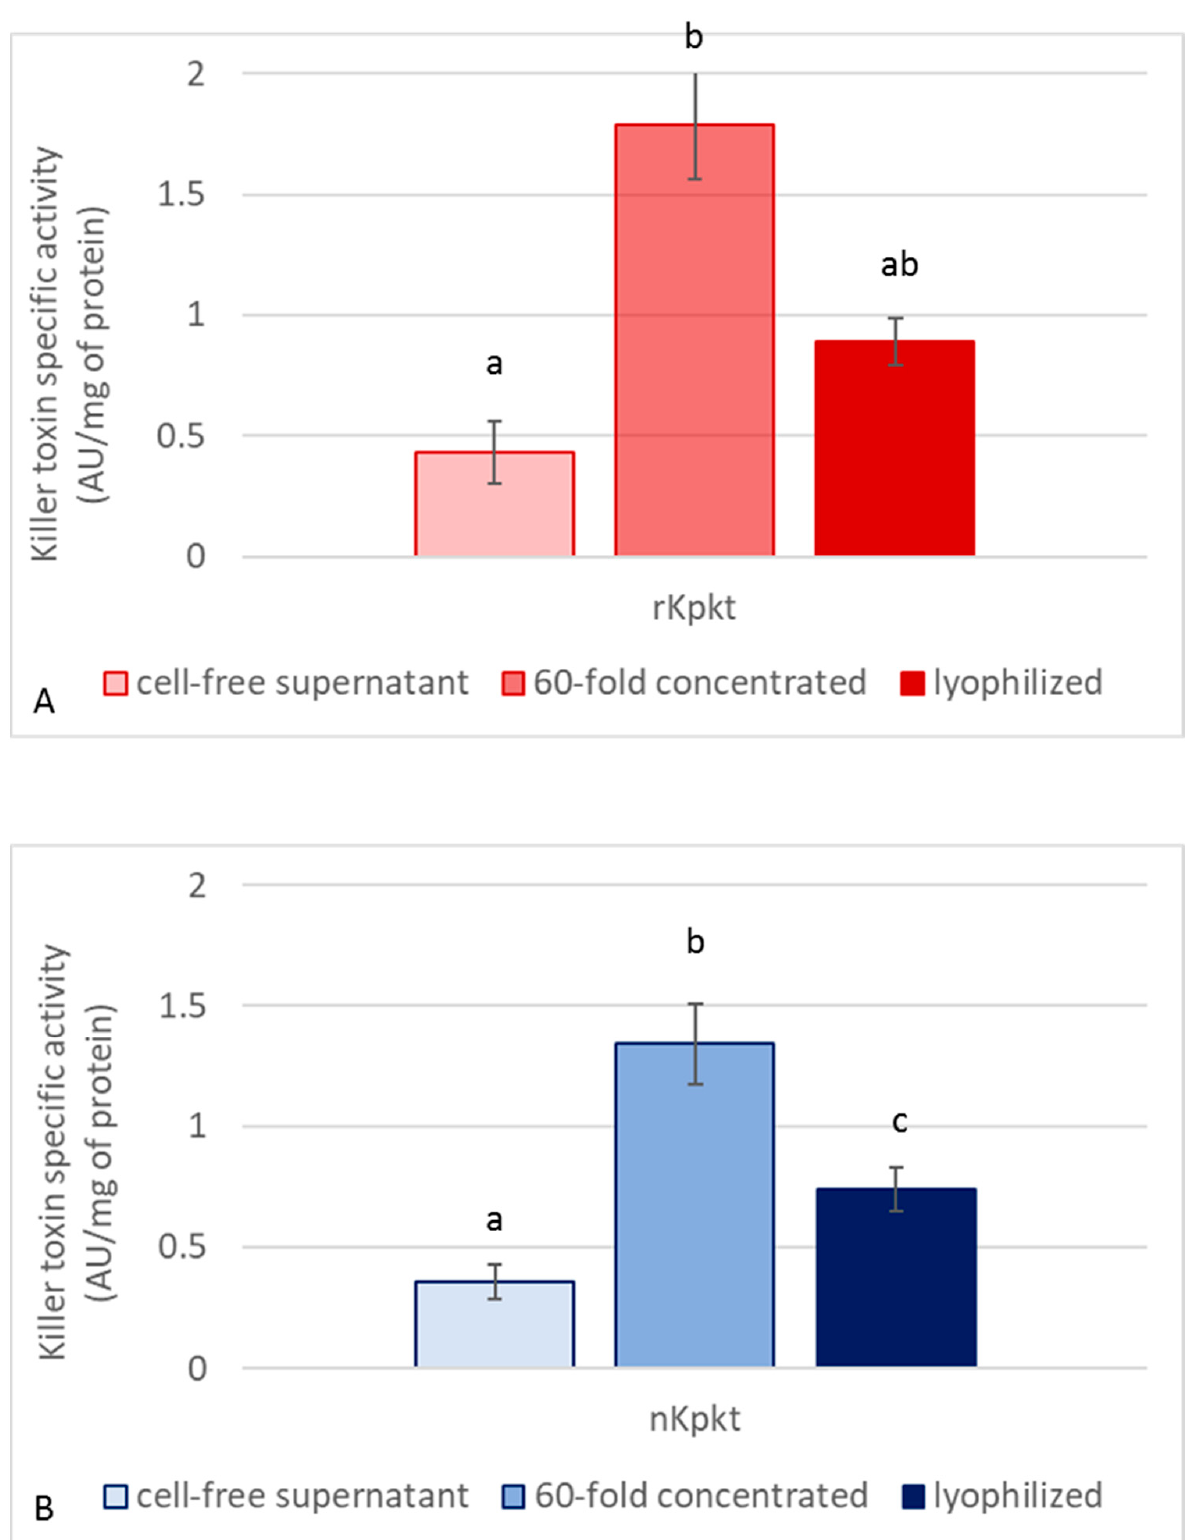
Figure 2. Specific killer activity of recombinant ( A ) and native ( B ) Kpkt. Killer toxin specific activity is expressed as AU/mg of protein. Results are means ± standard deviations of at least three independent experiments. Different letters indicate significantly different results ( p <